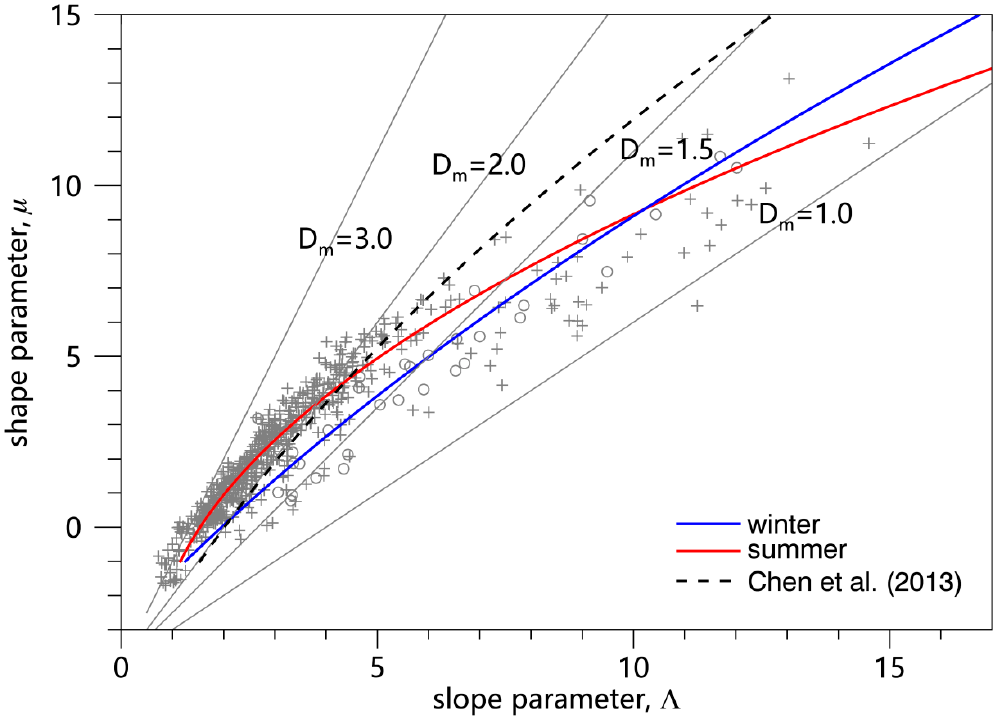
Figure 9. µ – Λ relationship scatterplots and fitting curves based on Parsivel disdrometer observations in two seasons. The gray circles represent winter precipitation samples and the gray crosses represent summer precipitation samples. The dashed line represents the empirical µ – Λ relationship of convective rain during Meiyu from Chen et al. [51]. The gray lines correspond to the relationship Λ D m = 4 + µ [39] given the value of D m = 1.0, 1.5, 2.0, and 3.0 mm.